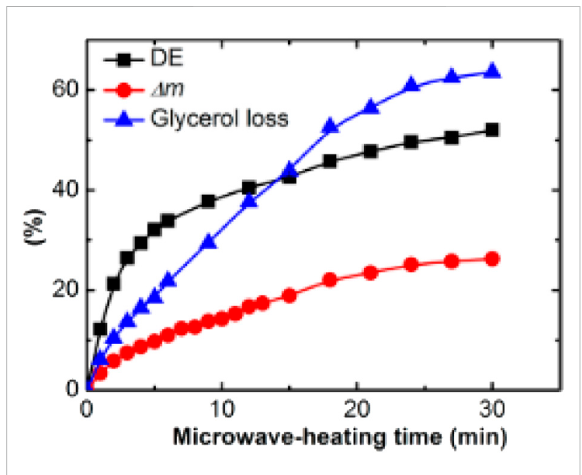
FIGURE 3 Evolution of the degree of esteri fi cation (DE), mass loss ( Δ m ), and glycerol loss values with increasing prepolymerization time during microwave heating (Li et al.,